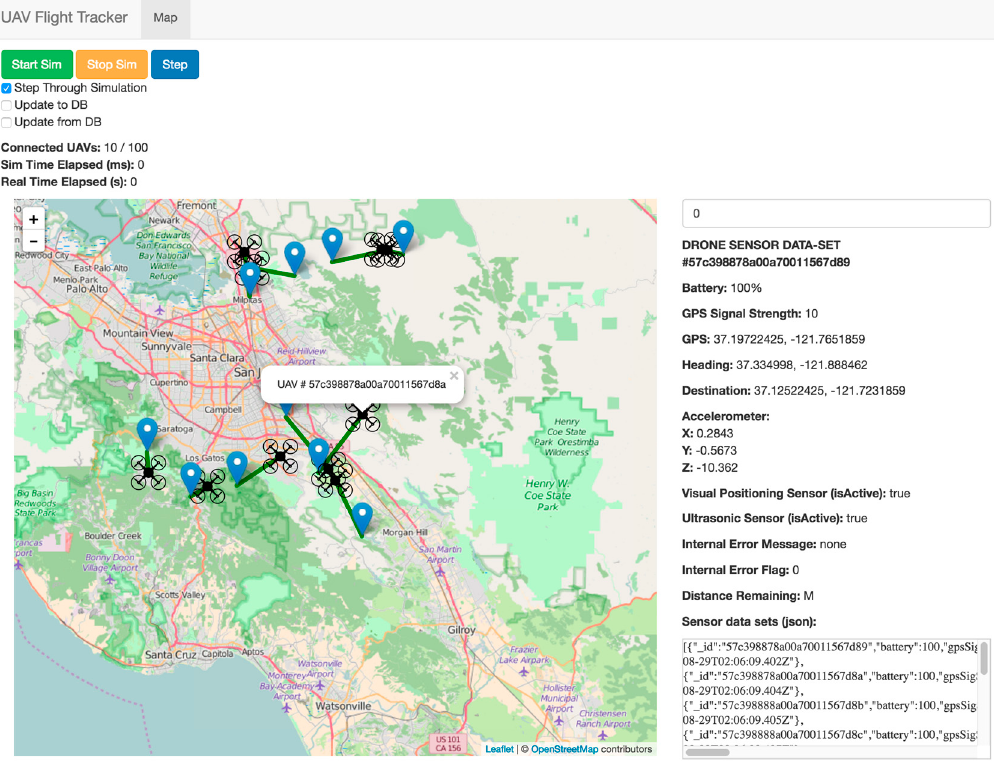
Figure 7. A screen on the client system.